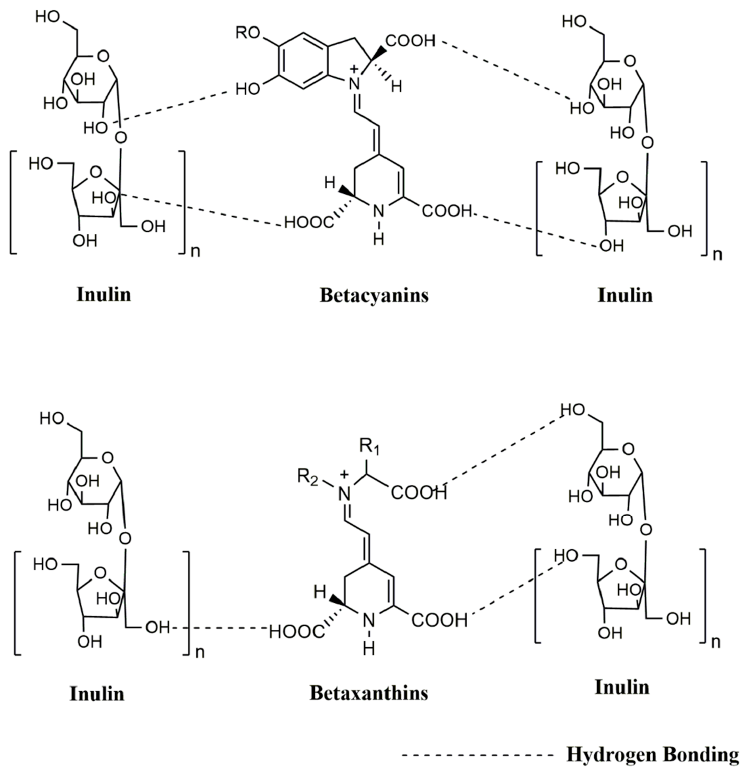
Figure 3. Interaction between inulin with betaxanthins and betacyanins.